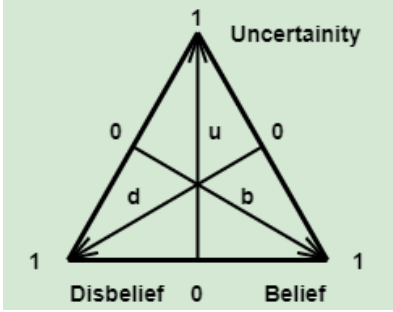
Figure 9. Opinion